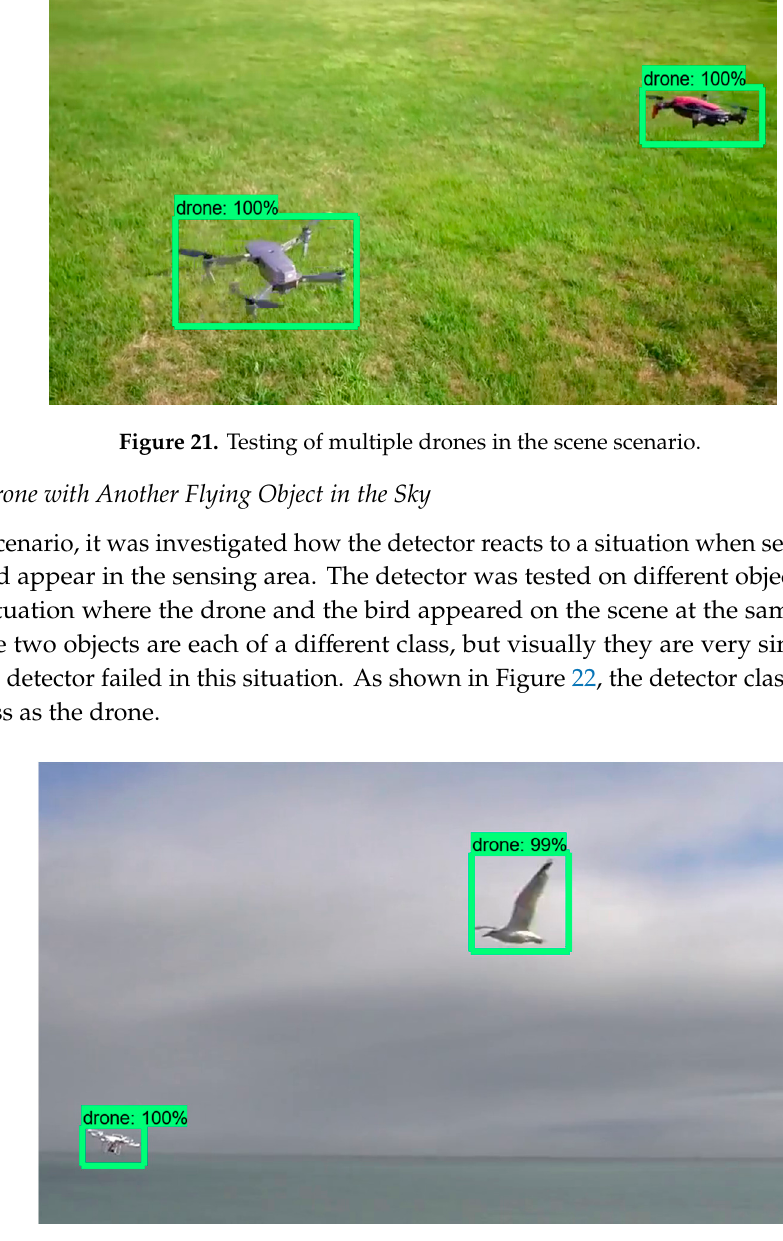
Figure 22. Testing the drone detection in the sky with another object.